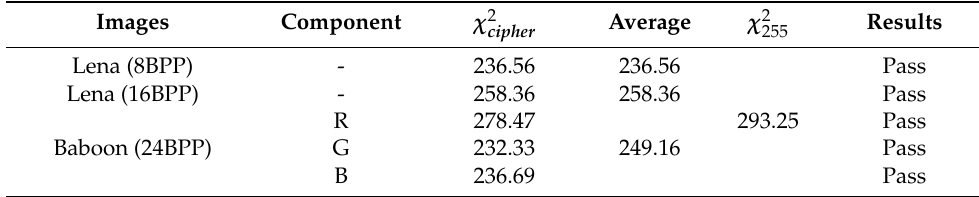
Table 13. Test about the pixel